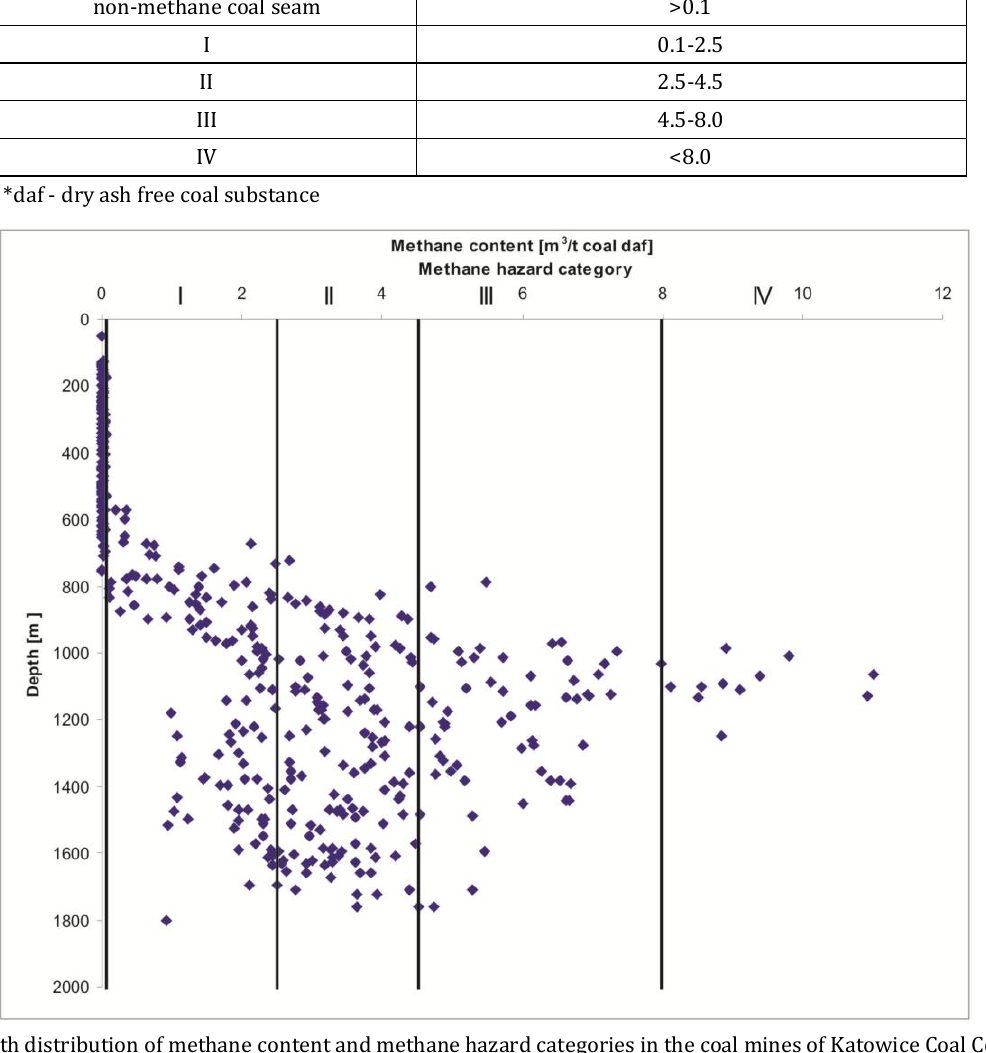
Table 1. Categories of methane hazard in hard coal mines in Poland Category of methane hazard